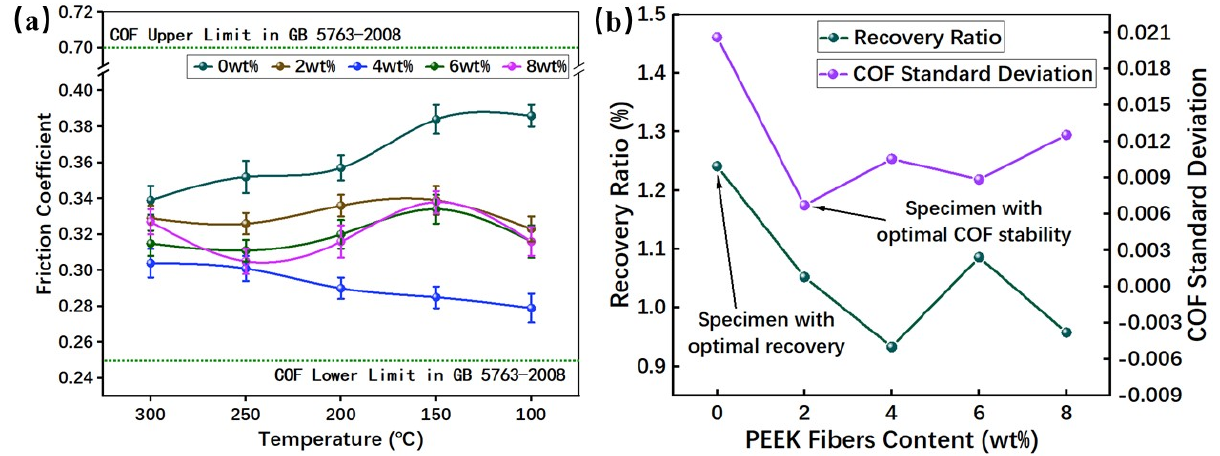
Figure 8. COF of the recovery test; ( a ) COF at each temperature, ( b ) recovery ratio and COF Standard Deviation.